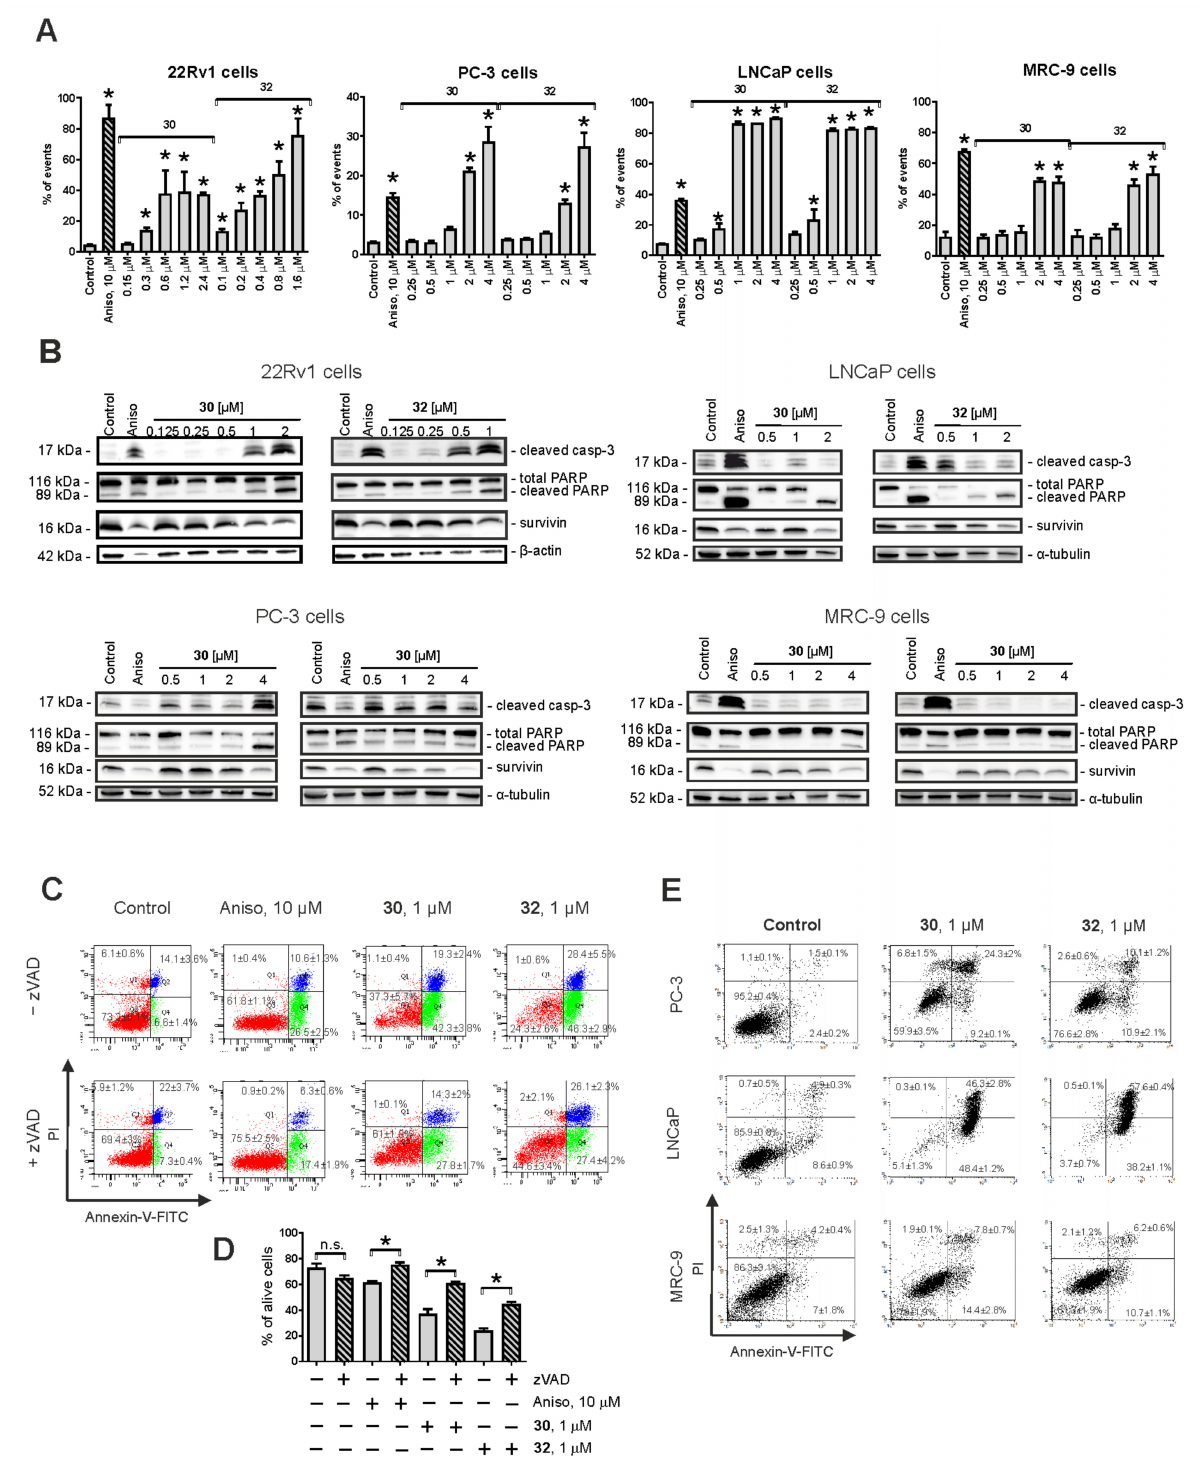
Figure 2. Pro-apoptotic activity of the synthesized compounds in 22Rv1, PC-3, LNCaP, and MRC-9 cells. ( A ) Analysis of drug-induced DNA fragmentation using PI staining and flow cytometry. Cells that appeared as sub-G1 population